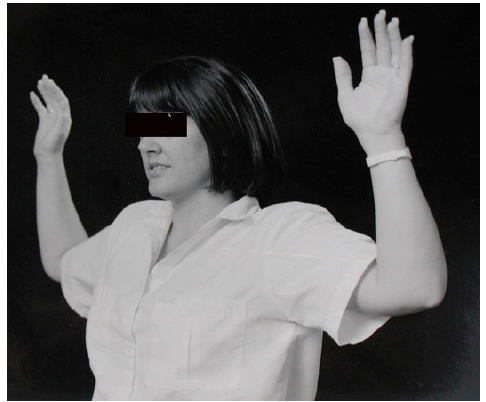
Figure 6. 90° Abduction in External Rotation (90° AER). Figure 6. 90 ◦ Abduction in External Rotation (90 ◦ AER).